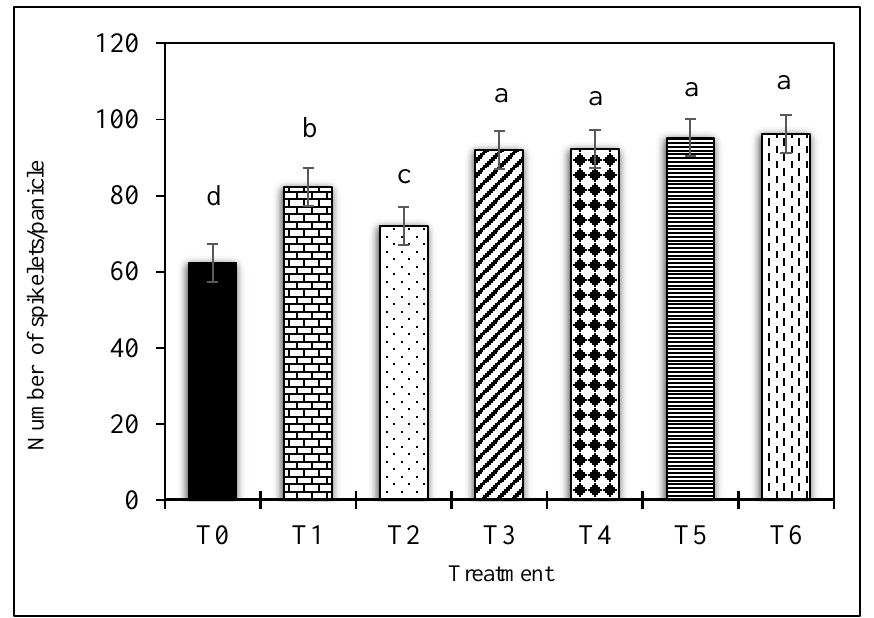
Figure 4. Effect of the different treatment combinations of N source on number of spikelets per panicle; mean of 4 replicates. Different letters indicate statistical differences ( p < 0.05), T0: no fertilizer, T1: 100% urea, T2: 100% beef cattle manure, T3: 100% poultry litter, T4: 50% urea + 50% beef cattle manure, T5: 50% urea + 50% poultry litter and T6: 40% urea + 30% beef cattle manure + 30% poultry litter.